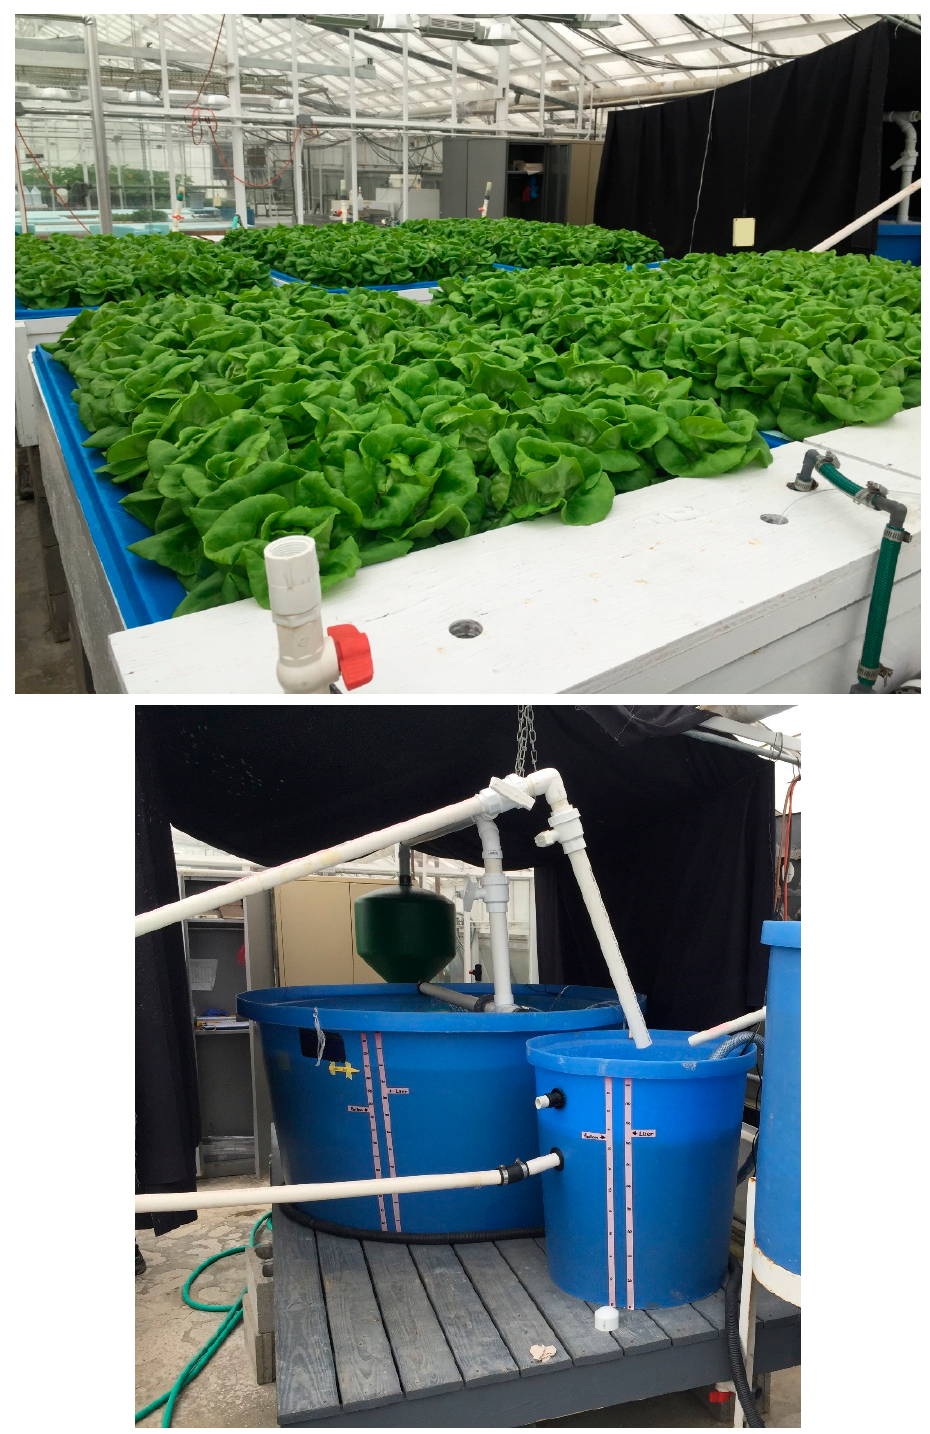
Figure 2. Photos of the operating system. ( Top ) The fish tank and bead filter are mostly hidden by the black curtains; the tubs are numbered 1–6 starting from top left and going clockwise; tubs 4 and 5 were dedicated to the fish system for treatment A7; the H5 and H7 treatments were rotated through the remaining tubs over the three trials. ( Bottom ) The activated charcoal water purification system (left side partially showing), settling/pumping tank, aquaculture tank, and bead filter (foreground to background) with piping to tub 4 and a return pipe to the settling/pumping tank.